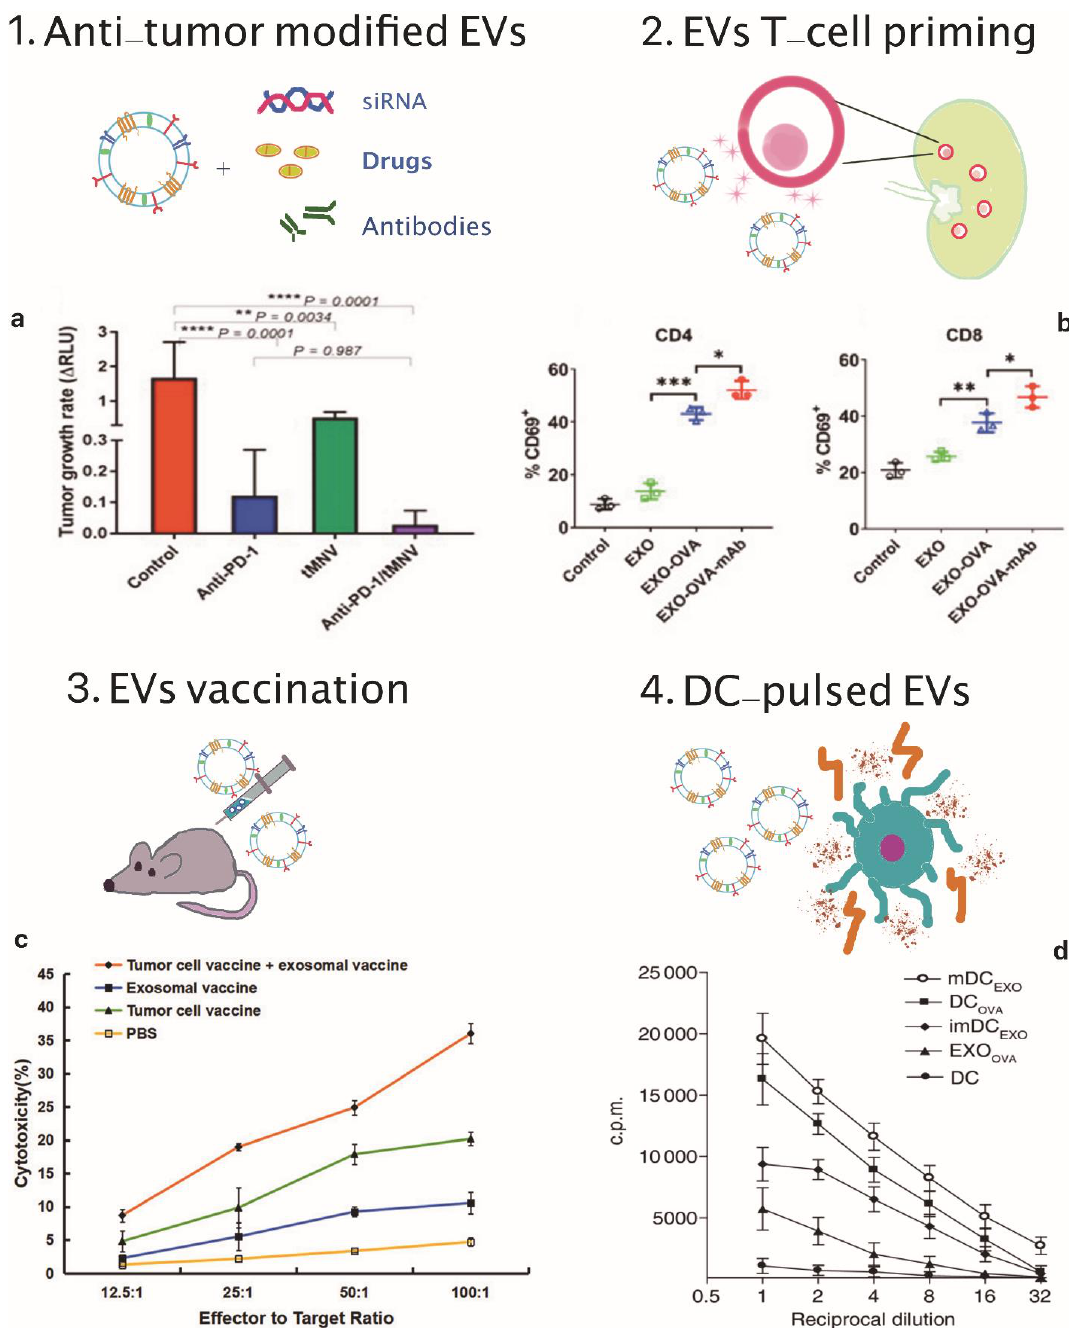
Figure 2. EVs applications in cancer immunotherapy. ( 1 ) Scheme of EVs as cargos of siRNAs, drugs and monoclonal antibodies and ( a ) therapeutic effect on tumor growth rate of anti-PD-1 and tMNV-directed therapy targeting B-catenin. Reproduced from [117] with the permission of Jhon Wiley and Sons. p -Values as indicated, one-way ANOVA analysis. ( 2 ) Scheme of EVs-mediated T-cell activation and ( b ) data analysis of CD69, a T-cell activation marker on CD4+ and CD8+ T cells following incubation with different exosomes formulations. Reproduced from [109] with permission of Elsevier. * p < 0.05, ** p < 0.01, *** p < 0.001, one-way ANOVA analysis. ( 3 ) Scheme of EVs vaccination and ( c ) tumor specific cytotoxic activity of the combination therapy involving exosomal vaccine and tumor cell vaccine against prostate cancer cells. Reproduced from [110] with permission of John Wiley and Sons. ( 4 ) Scheme of DC-pulsed EVs and ( d ) proliferative response of CD8+ T cells co-cultured with EXOOVA (10 µ g/mL), DCOVA, mDCEXO and imDCEXO (3 × 10 4 cells/well), determined by (3H)thymidine uptake assay after two days. Reproduced from [111] with permission of Jhon Wiley and